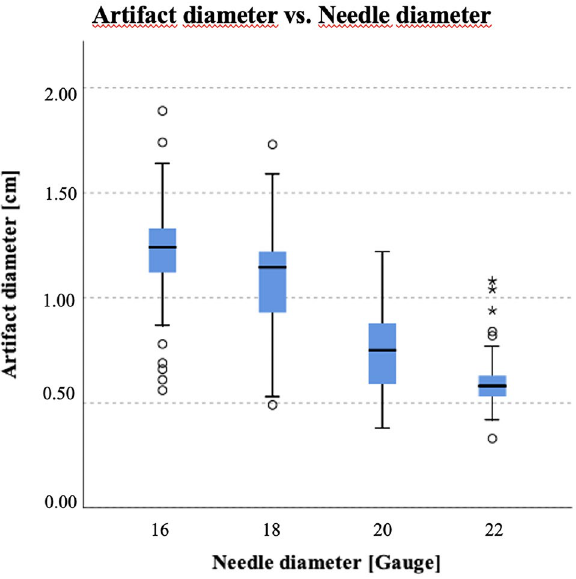
Figure 5. Boxplot of artifact size depending on needle diameter. Medians (of both readers) of all measured artifact diameters of all modified parameters separated in 16G, 18G, 20G, 22G needles. Kruskal–Wallis test demonstrated a significant difference of artifact diameter ( p < 0.001) for the 4 sizes of MR-compatible needles.